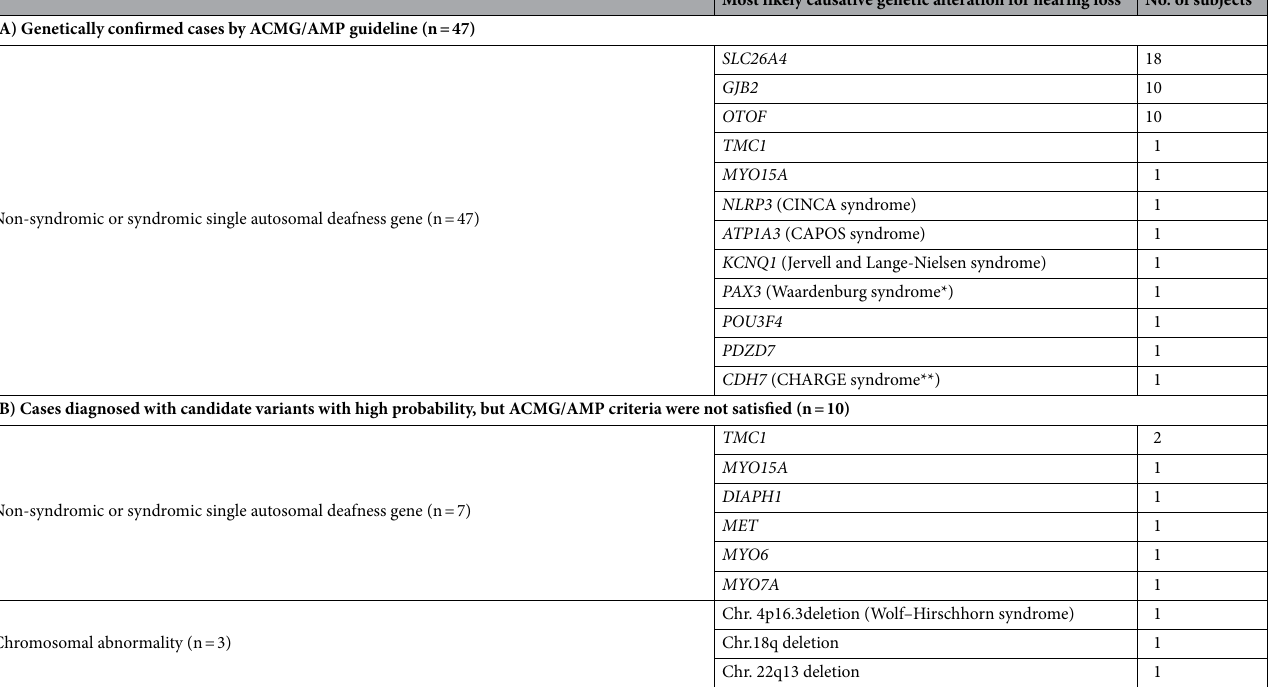
Table 2. Molecular genetic etiology of pediatric severe to profound hearing loss in our cohort. Our cohort includes two Waardenburg syndrome subjects*, only one of whom turns out to carry a PAX3 variant and four CHARGE syndrome subjects**, only one of whom has a CHD7 variant. The 3q deletion detected from SB318- 627 was excluded from the final list due to uncertainty of causality of